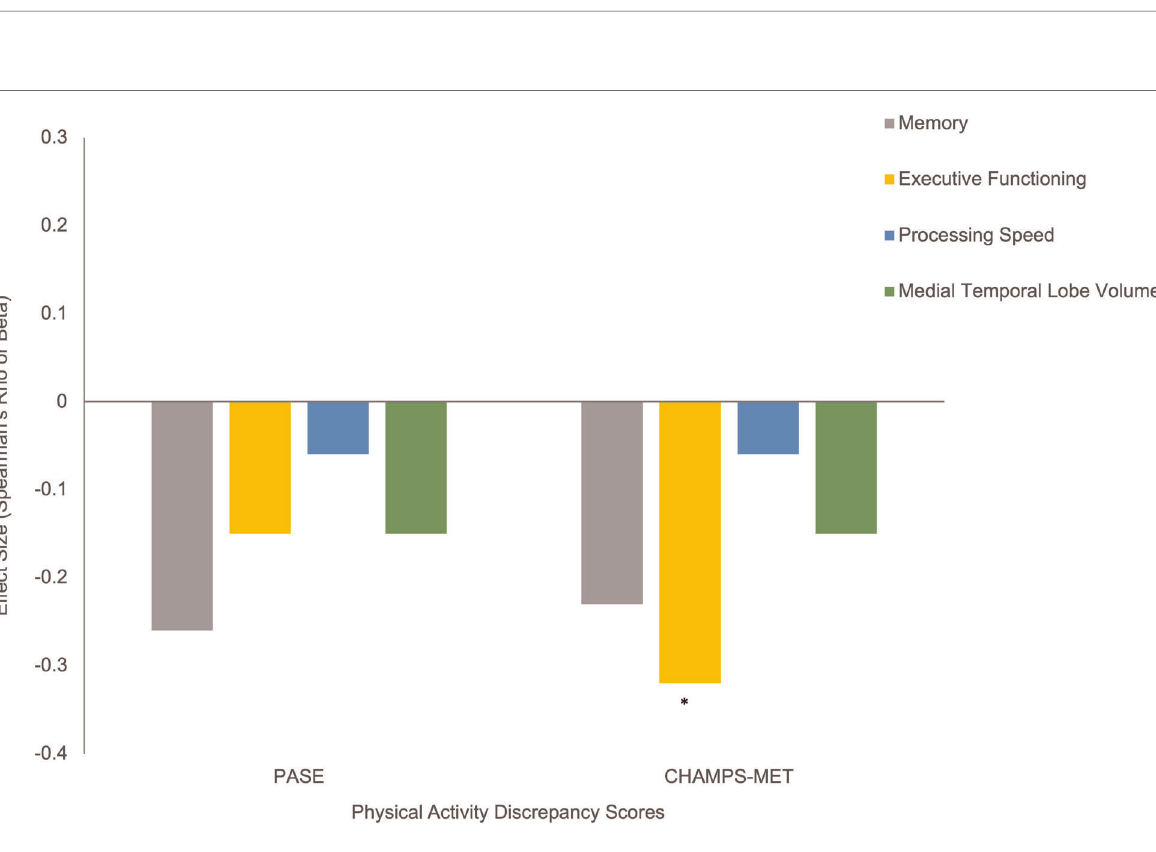
FIGURE 4 Demographic and cardiometabolic correlates of physical activity overreporting positive discrepancy score indicates greater overreporting). Note. *Statistically signi fi cant at p <0.05.